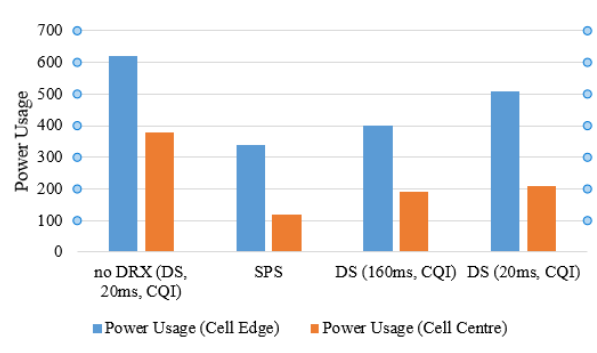
Fig. 10. Average power usage for VoLTE over LTE [7]